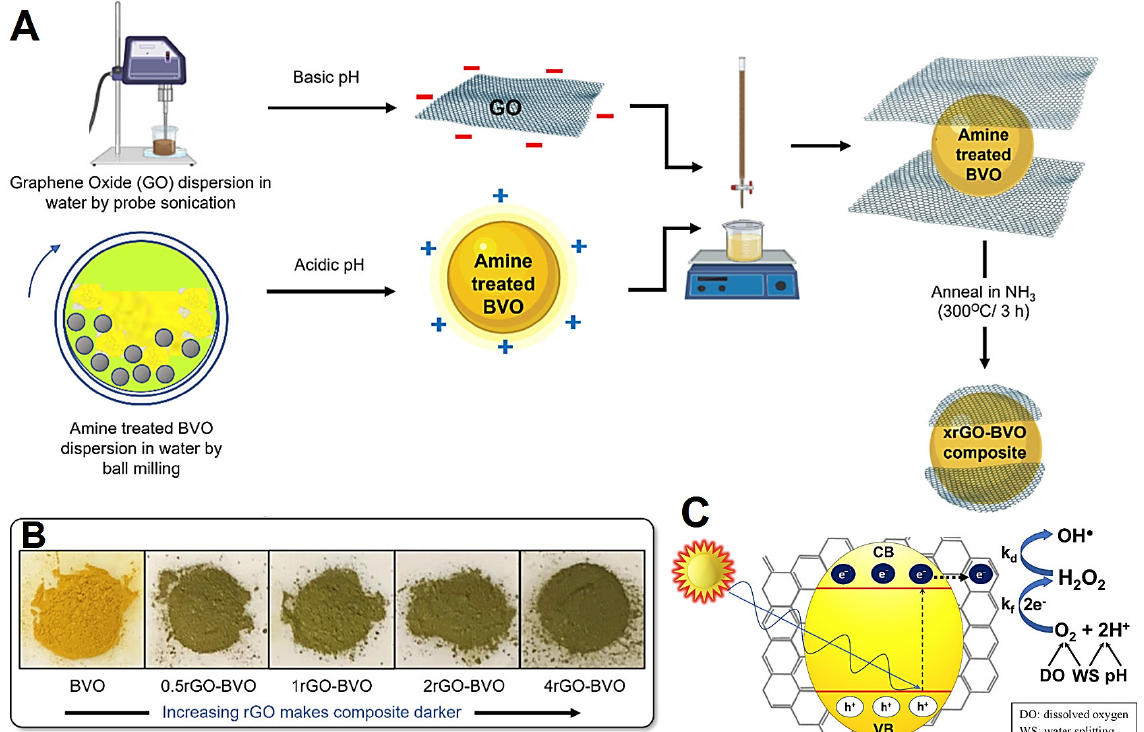
Figure 2. ( A ) The encapsulation of BiVO 4 (BVO) with reduced graphene oxide (rGO). ( B ) Digital photographs of the commercial BVO and the prepared composites. ( C ) Mechanism of photocatalytic generation of H 2 O 2 . Adapted from [66] with permission. Copyright 2021 American Chemical Society.